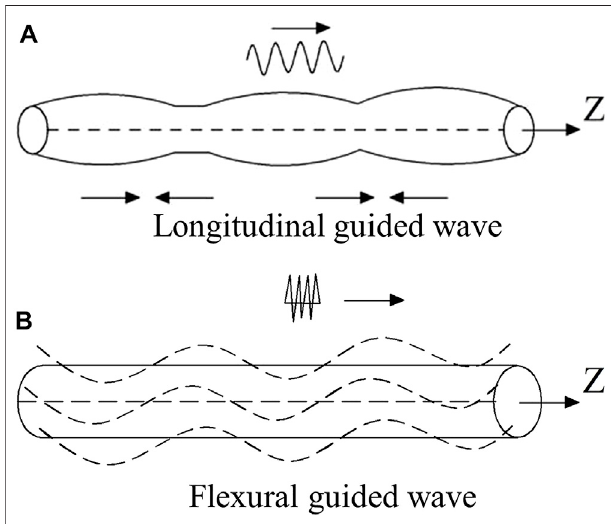
FIGURE 2 | Wave propagation modes in a waveguide.